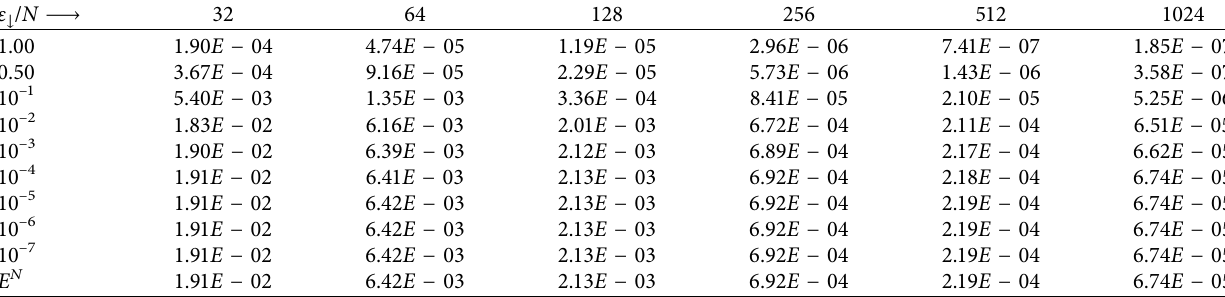
Table 1: Result of Example 1 (maximum pointwise error) for δ � η � 0.5 ∗ ε .